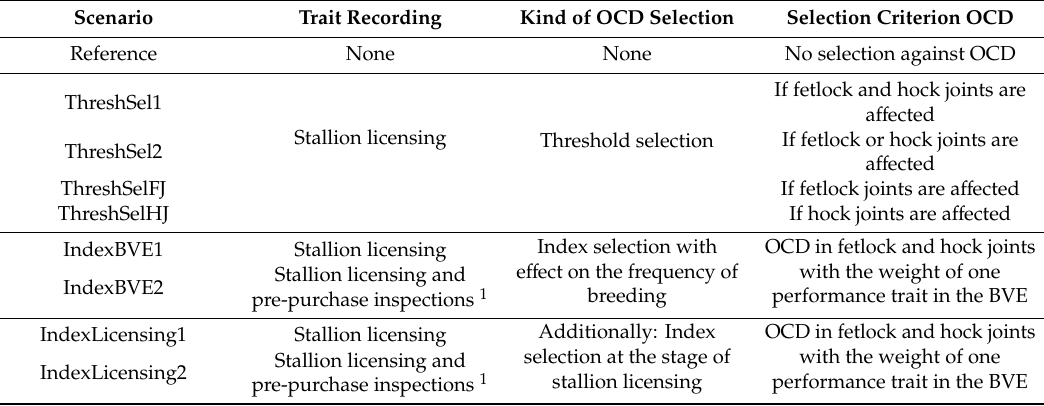
Table 4. Reason for trait recording and selection criteria with regard to OCD for seven di ff erent simulation